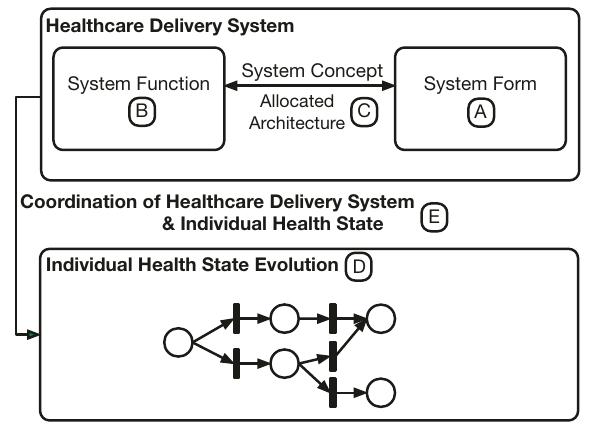
Figure 1: Healthcare System Architecture includes the healthcare delivery system, the individual health state, and their